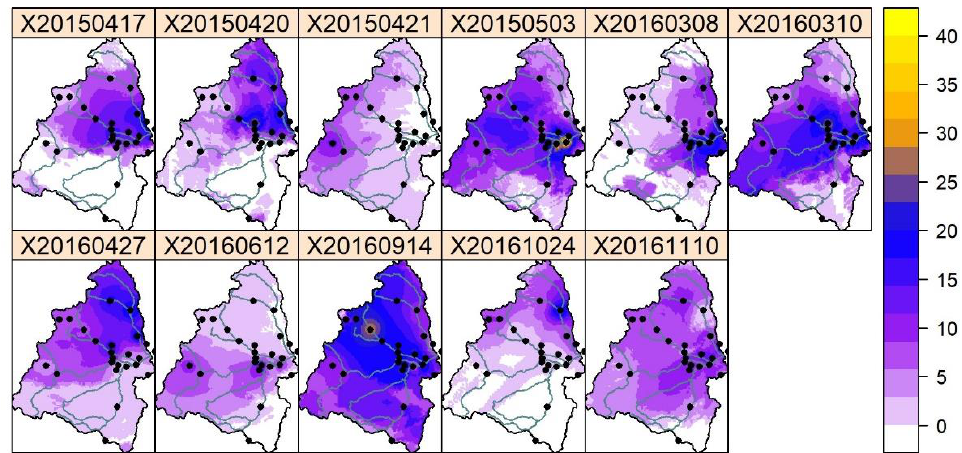
Figure 3. Rain distribution and total accumulation (mm per event) for the time period shown in Table 2 (duration) within the Cuenca sub-basin for the 11 events. Black dots represent the rain gauge network. The maps were created using the adjusted radar data.